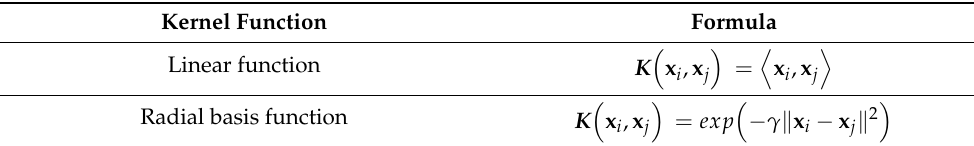
Table 3. Representative kernel functions of SVR used in this study.